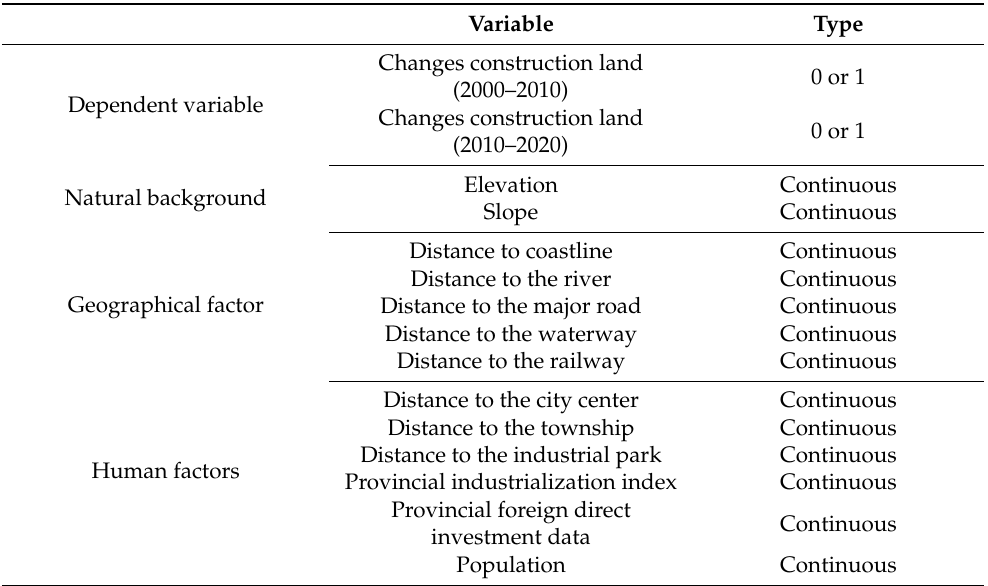
Table 3. Impact factors index